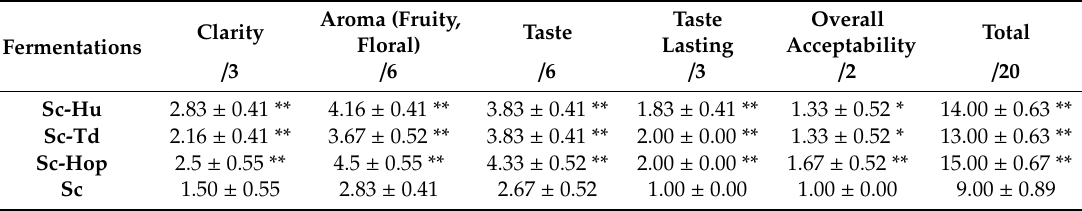
Table 4. Sensory evaluation scores of citrus